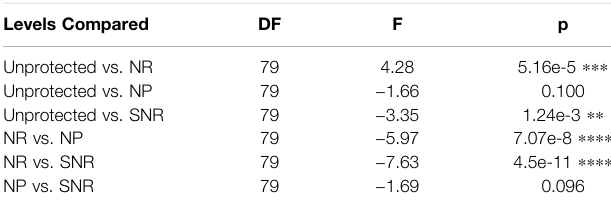
TABLE 1 | Results from a Bonferroni test indicating differences between changes in annual precipitation at each protection category. Statistical signi fi cance is indicated by p